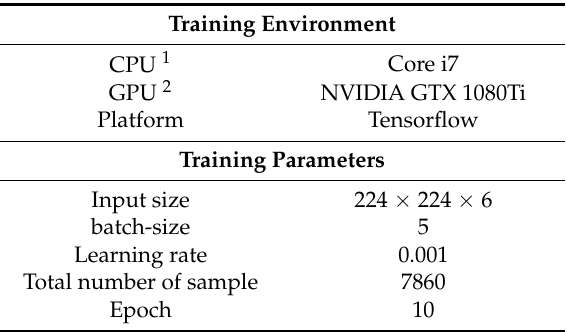
Table 6. The main parameters of U-Net network training.